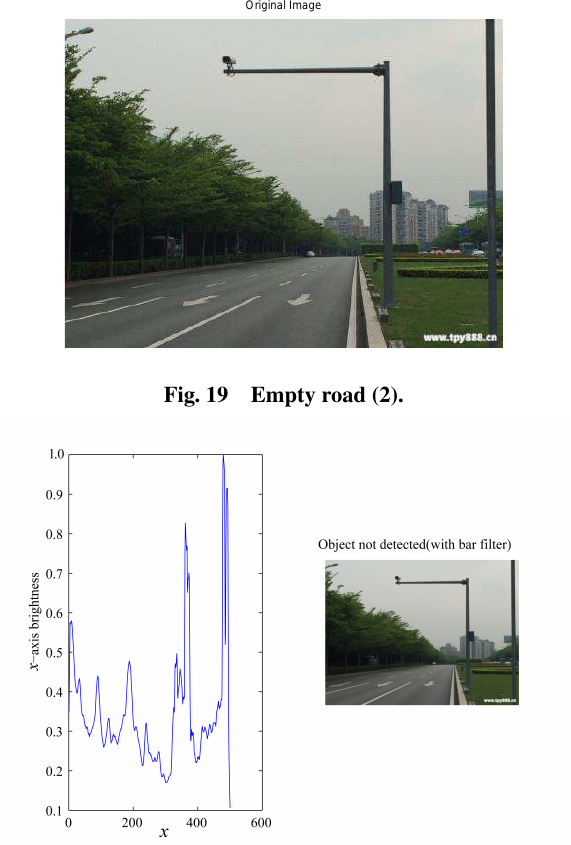
Fig. 20 Horizontal axis’ brightness values and search result (with bar filter) according to Fig.